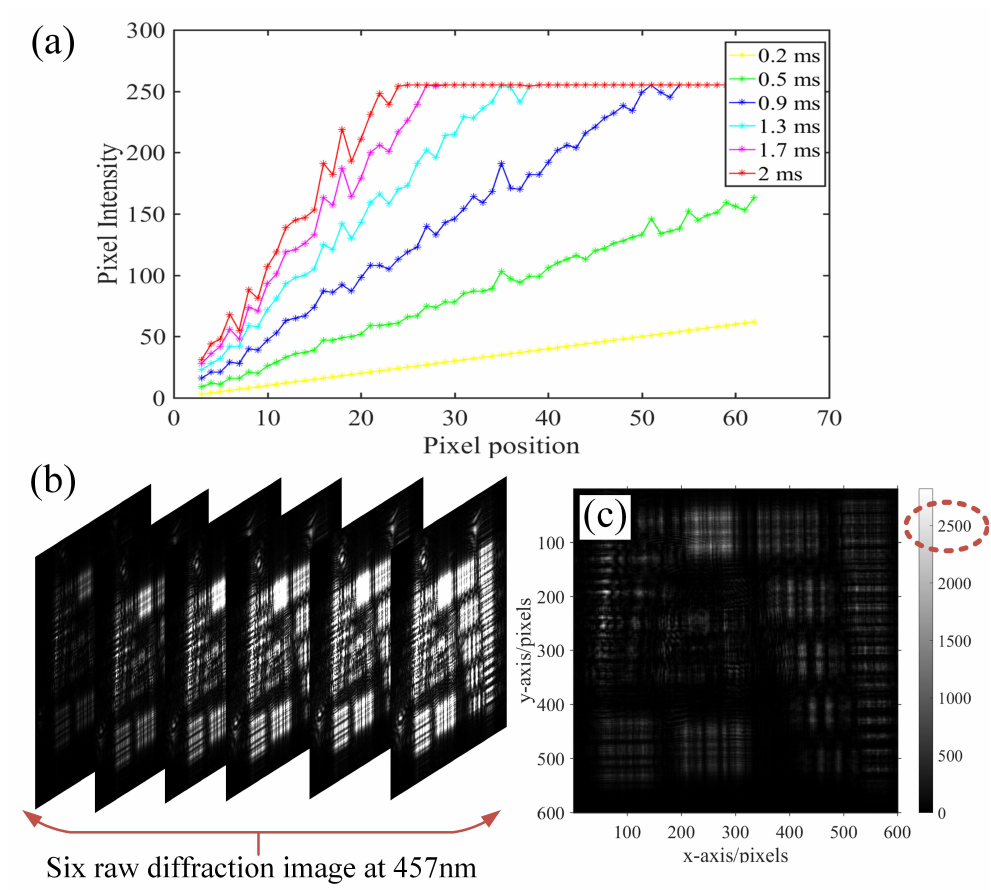
Figure 3. ( a ) Pixel intensity recorded at the same location have different values in different exposure conditions. ( b ) Six raw diffraction images with different exposure times at 457 nm. ( c ) The HDR diffraction image at 457